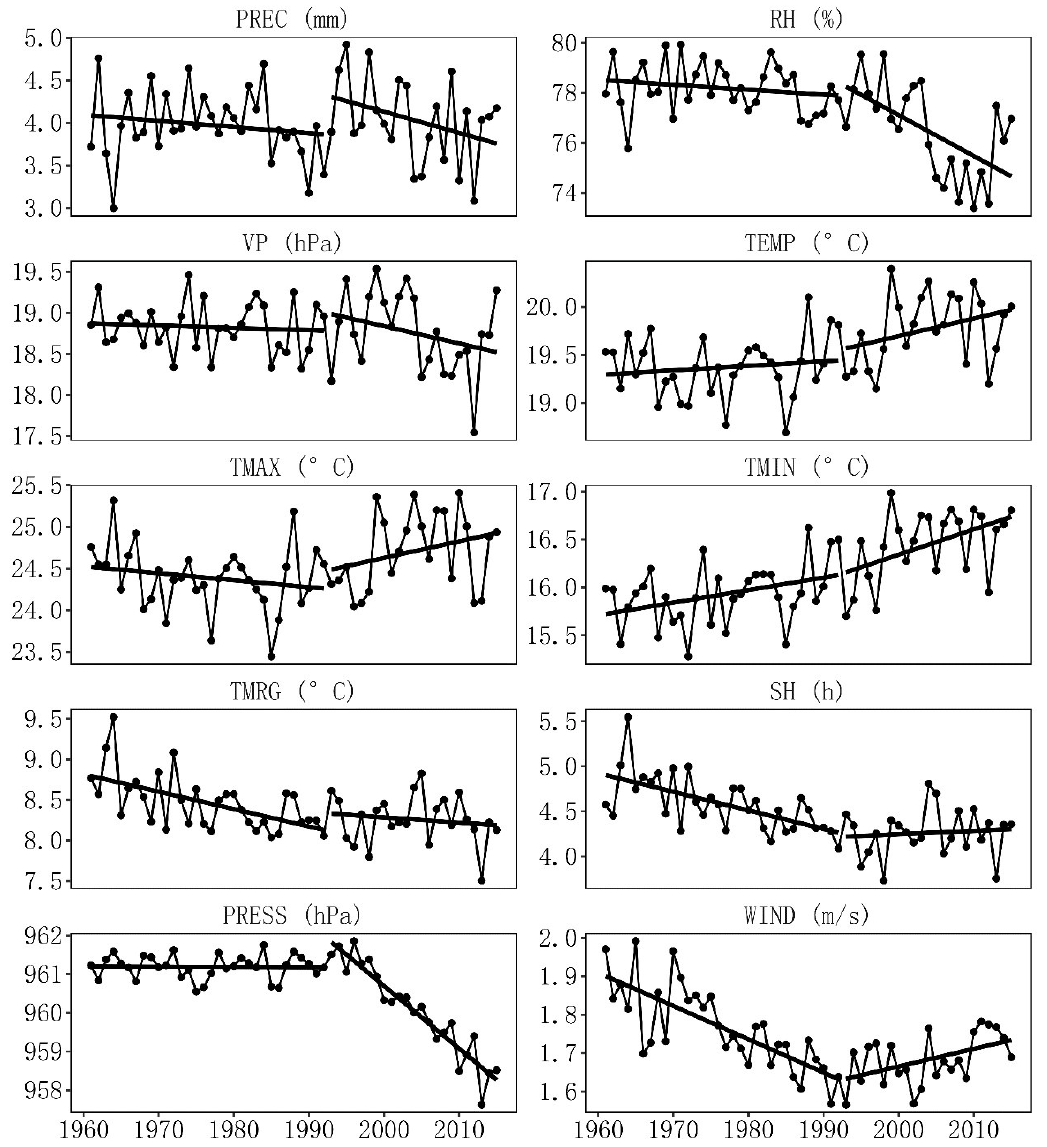
Figure 7. Variation trends ( α = 0.05) of the ten climatic factors in the Pearl River Basin.